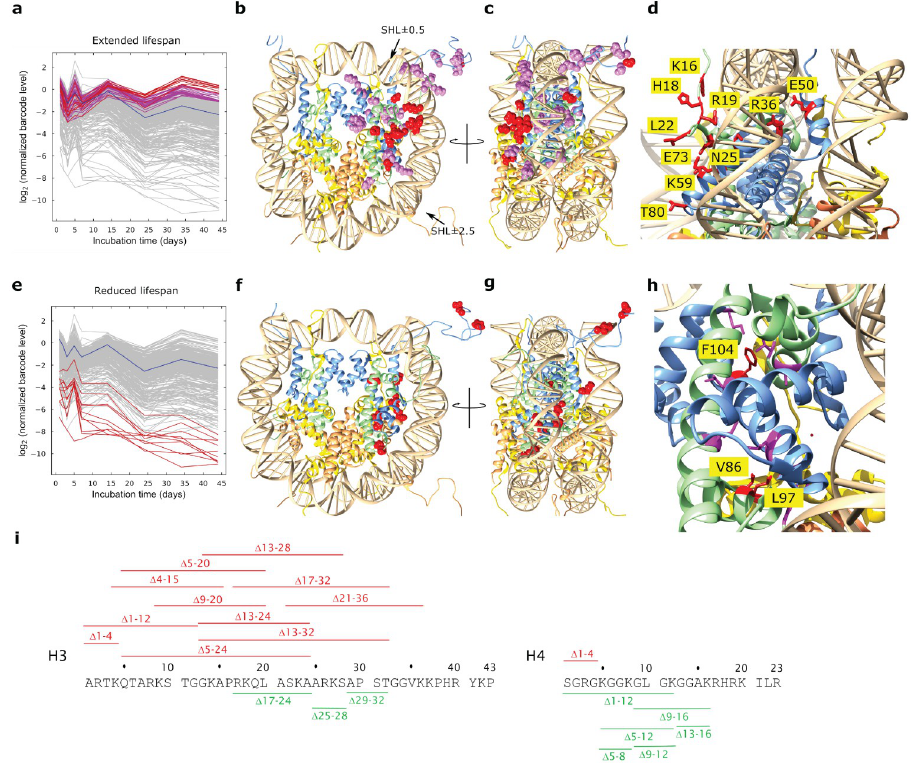
Fig 1. Chronological lifespan of histone mutants. The barcode level of each of the approximately 400 tagged histone mutant strains was determined by sequencing in the quiescent pool at different times in stationary phase, and expressed as log 2 relative to the level at the start of stationary phase (6d), and adjusted to the population median. The log 2 ratios of the top 10 individual (red) and top 10% (violet) of strains with most extended lifespan ( a ) and bottom 10 individual strains (red) with most reduced lifespan ( e ) are shown at progressive times of incubation. The log 2 ratio of the median strain is indicated (blue). The residues implicated in the top 10 individual and top 10% of strains that exhibit extended lifespans are shown in red and violet sphere conformation in the structure of the nucleosome (1KX5), respectively ( b ), and the bottom 10 individual strains with the most reduced lifespans are shown in red sphere conformation ( f ). The positions of superhelix locations (SHL) ± 0.5 and ± 2.5 aligned with the Sin and Lrs sectors [29] are indicated by arrows ( b ). The structures in b and f are shown rotated by 90˚ clockwise viewed from the top ( c , g ). The 10 individual residues associated with most extended ( d ) and most reduced ( h ) lifespan are shown in stick conformation with individual residues identified. The deletions of sections of the N-terminal tails of H3 and H4 that are associated with extended (green) or reduced (red) CL are indicated ( i ). Individual residues atoms of the mutated residue in the top 10 most viable ( b ) and 10 least viable ( e ) strains in the quiescent fraction are shown as red spheres in the crystal structure of the nucleosome (PDB accession 1KX5). A close-up view of the nucleosome shows the location of the mutated residues, represented in red stick structures, in the most ( c ) and least viable ( f )